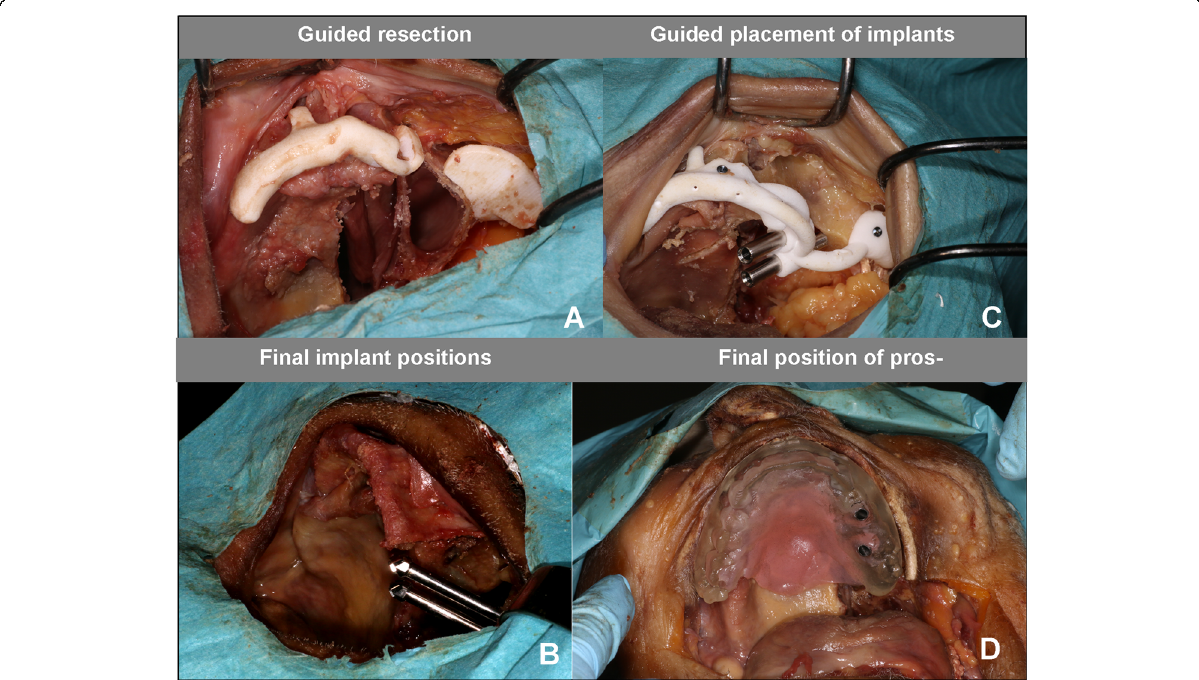
Fig. 2 Overview of the surgical procedure. The working method starts with left-sided maxillectomy guided by the surgical template ( a ). Next, the drill-guide was fixed to the bone on two anatomical locations (zygoma and premaxilla) using 2.0 mm cortical locking screws and two zygomatic implants were guided placed in the planned positions ( b ). Finally, prosthetic cylinders were fixated to the obturator prosthesis with light cured resin to fixate the prosthesis firmly on the zygomatic implant abutments ( d